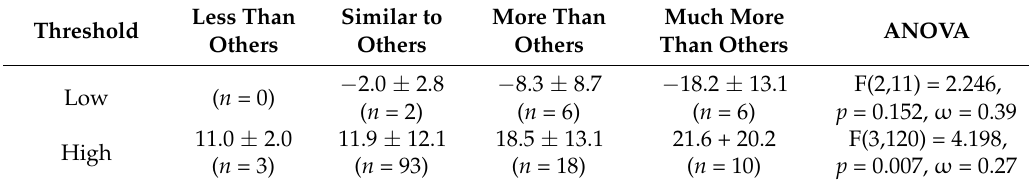
Table 3. Average calculated threshold axis scores for participants in each normative category of the Adult/Adolescent Sensory